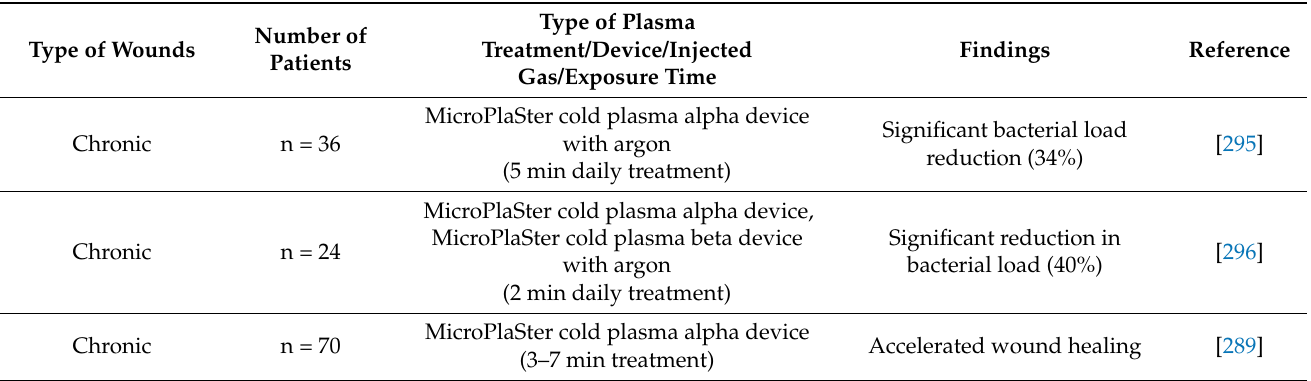
Table 4. Representative list of the cold atmospheric plasma treatment-based applications on chronic and acute wound